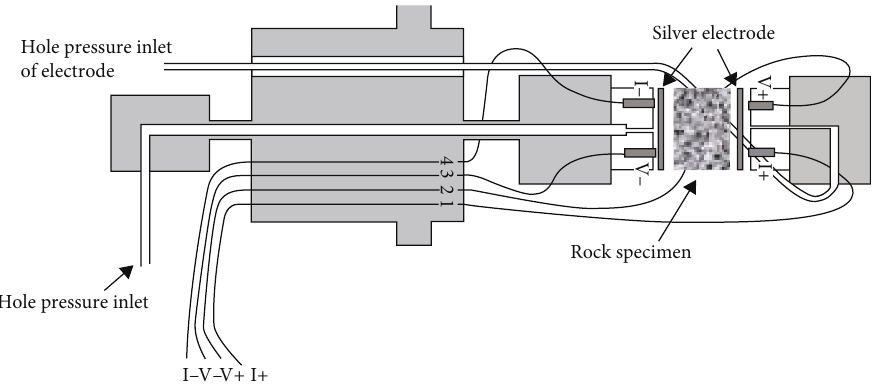
Figure 3: Schematic diagram showing the principle of the complex resistivity measurements.